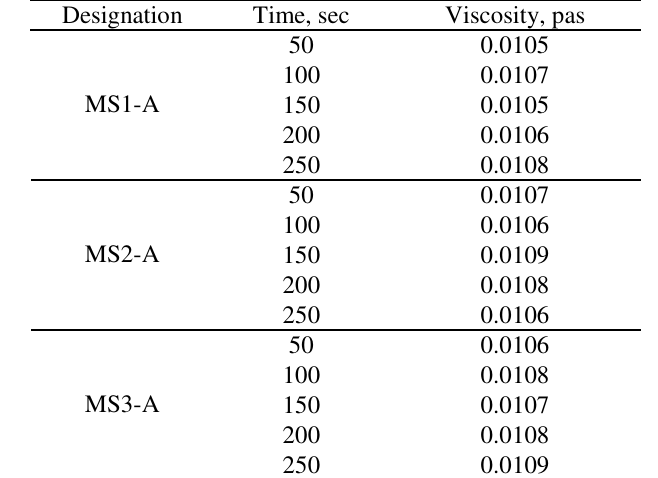
Table 4. Viscosity of maleated shellac acrylic resin surface coating material with time at 25 0 C